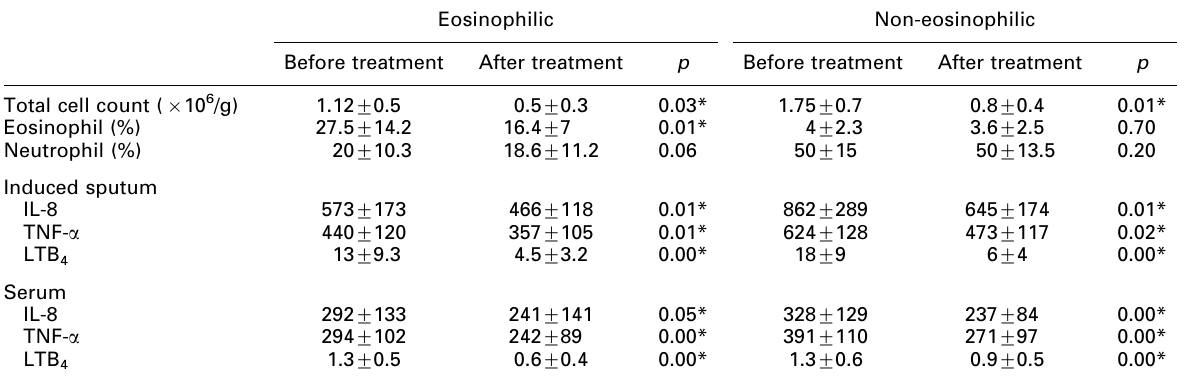
Table 3. Comparison of before and after treatment-induced sputum cells and inflammatory marker levels in eosinophilic and non-eosinophilic subjects Eosinophilic Non-eosinophilic Before treatment After treatment p Before treatment